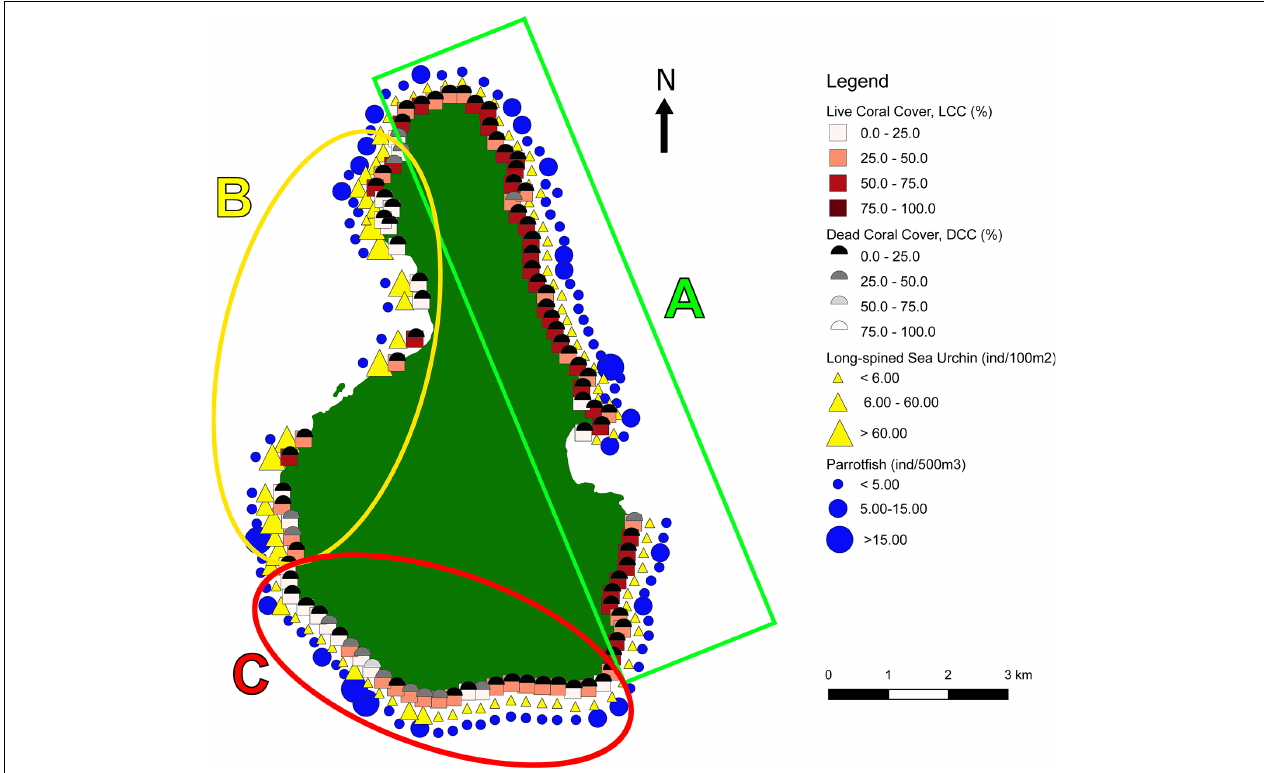
FIGURE 1 | Map showing four Reef Check indicators (Live Coral Cover, Dead Coral Cover, Long-spined Sea Urchin and Parrotfish) at each of the 95 survey sites, with three distinctive zones of A (green), B (yellow) and C (red) determined via visual analysis.